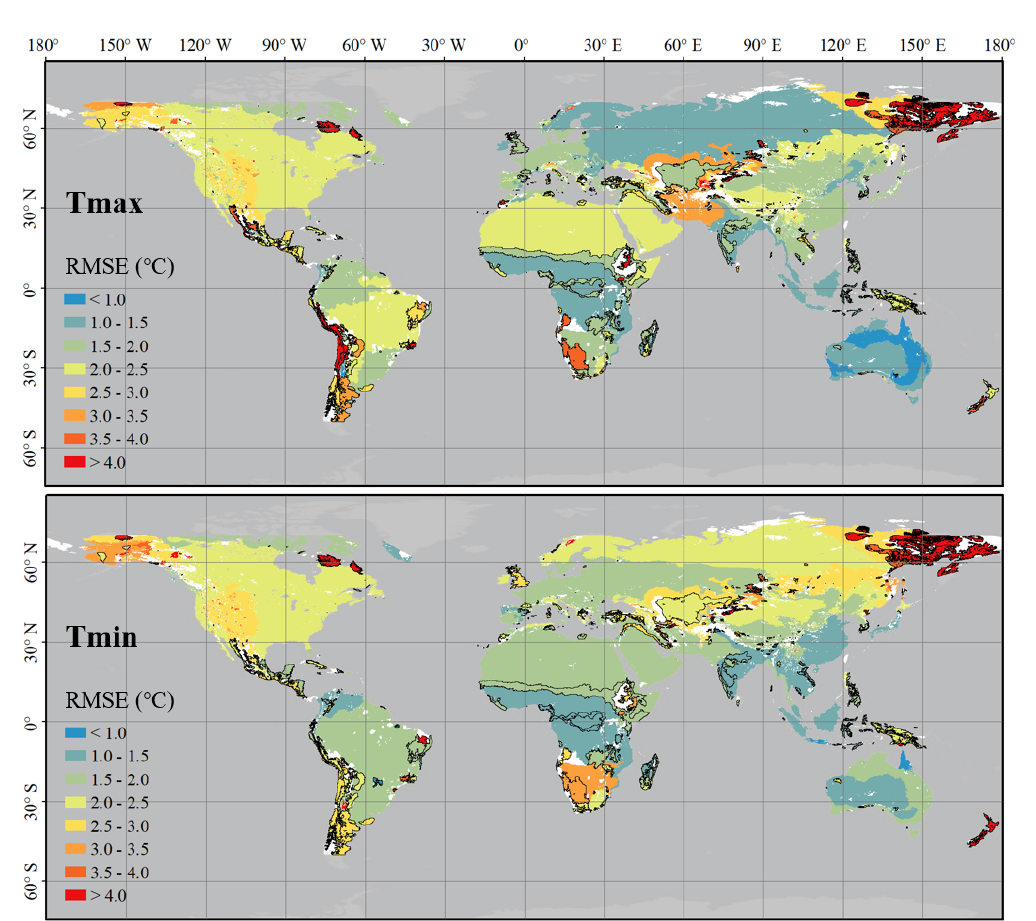
Figure 4. Accuracy of estimated T a in climate zones in 2003–2020. Climate zones with black boundaries are areas with low densities of weather stations (i.e., distances between training and validation sites are larger than 50km). The white regions on land are areas without reliable evaluations due to the lack of weather